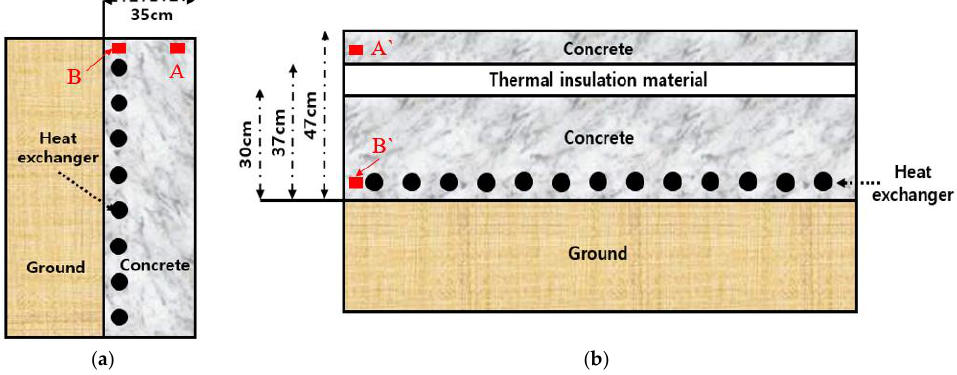
Figure 3. Sectional view of energy slab. ( a ) Wall slab; ( b ) Floor slab.